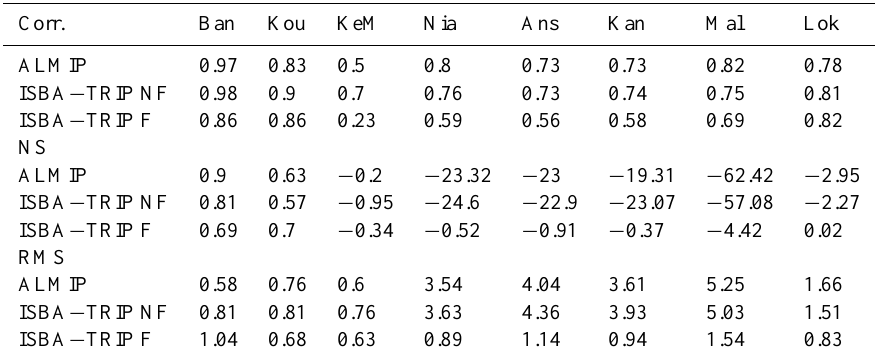
Table 2. Daily statistic scores of the discharge for the ALMIP LSMs and ISBA/TRIP with and without flooding from 2002 to 2004. TRMM- 3B42 is used as forcing. Corr. Ban Kou KeM Nia Ans Kan Mal Lok ALMIP ISBA − TRIP